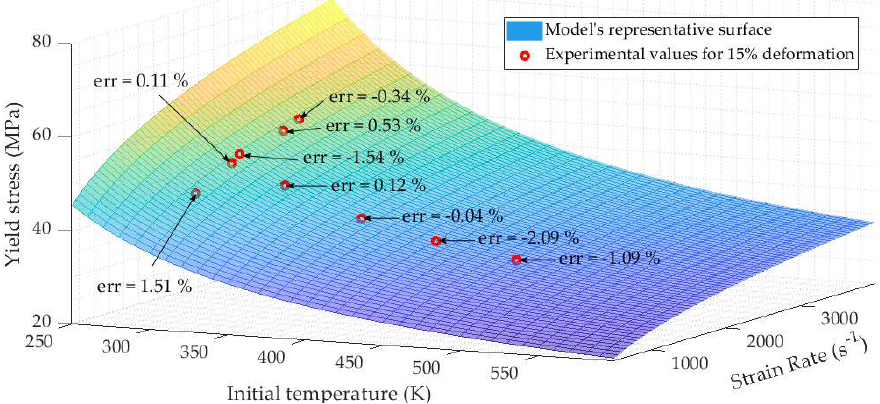
Figure 19. 3d representation of the yield stress field and experimental points.